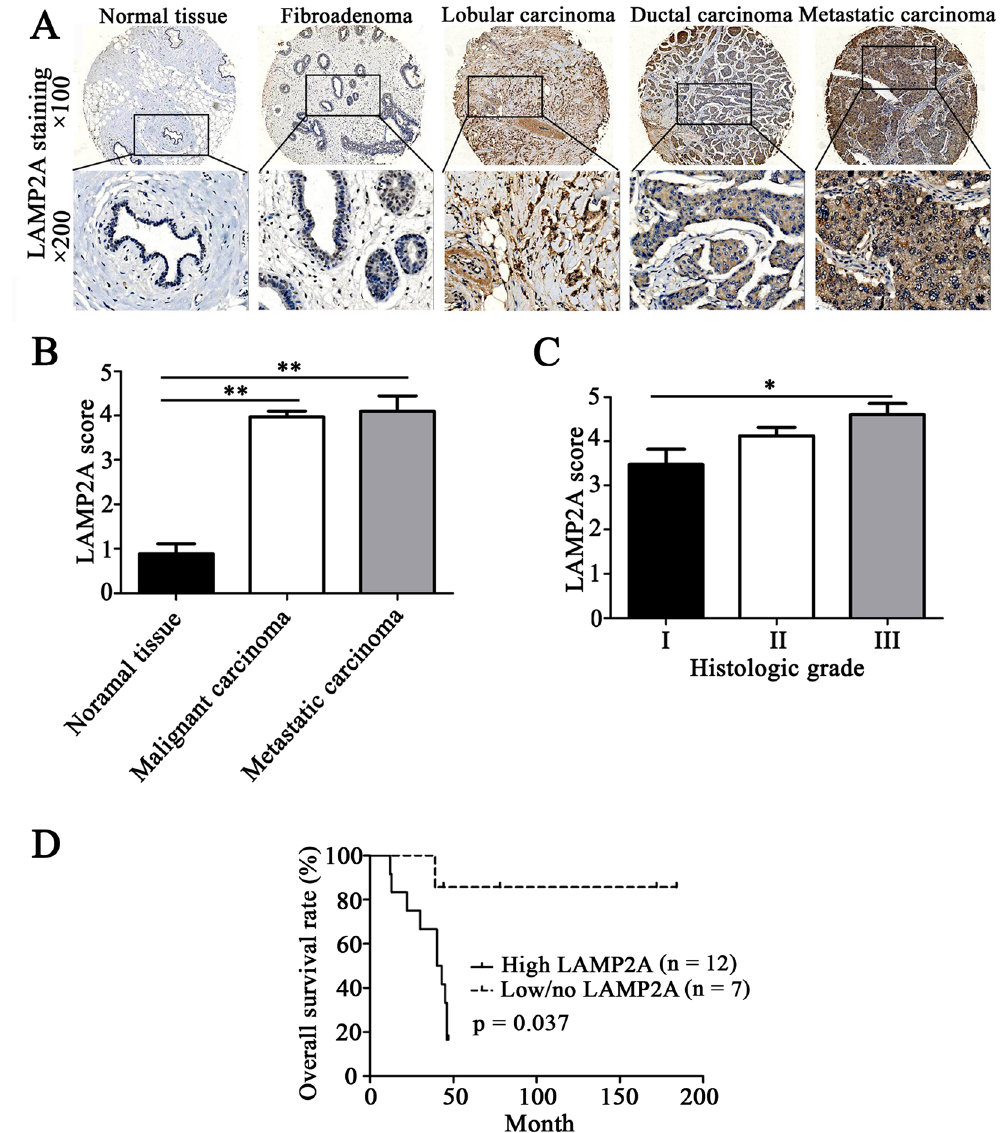
Figure 1. CMA activity is elevated in human breast cancer. ( A ) Immunostaining for LAMP2A in normal breast epithelium tissues, fibroadenoma, breast cancer and metastatic lymph node tumor tissues (100 × and 200 × ). ( B ) Immunoreactivity scores of LAMP2A levels in normal tissues, malignant carcinoma and metastatic carcinoma. ( C ) Immunoreactivity scores of LAMP2A in tumors of different histologic grades. Among all the invasive ductal carcinoma tumors, 21 were Grade I, 74 were Grade II, and 28 were Grade III. ( D ) Kaplan–Meier plots of LAMP2A expression in 19 cases of breast cancer patients. Overall survival rate was determined by the log-rank test. Each sample was assigned an immunoreactivity score that calculated the sum of the intensity of positive tumor cells (0 = none; 1 = weak; 2 = intermediate, 3 = strong) and the estimated fraction of positive staining tumor cells (0 = none, 1 ≤ 10%, 2 = 10–50% and 3 ≥ 50%) ranging from 0 and 2–6. We identified TMA scoring > 3 as LAMP2A-positive tumors and TMA scoring ≤ 3 as LAMP2A-negative tumors ( * P < 0.05, ** P <